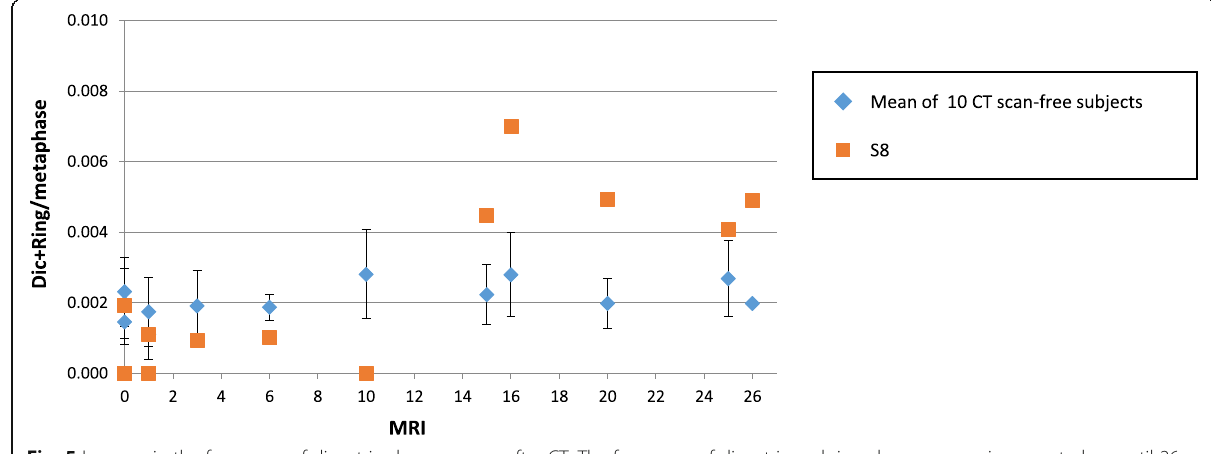
Fig. 5 Increase in the frequency of dicentric chromosomes after CT. The frequency of dicentric and ring chromosomes is presented up until 26 MRI sessions for the ten MRI-only volunteers and for the subject number 8, a volunteer exposed to computed tomography examinations (8 between the 10 and 25 MRI sessions) for an unexpected diagnostic assessment of a non-brain pathology during the originally planned MRI sessions schedule. Dic , Dicentric chromosomes; MRI , Magnetic resonance